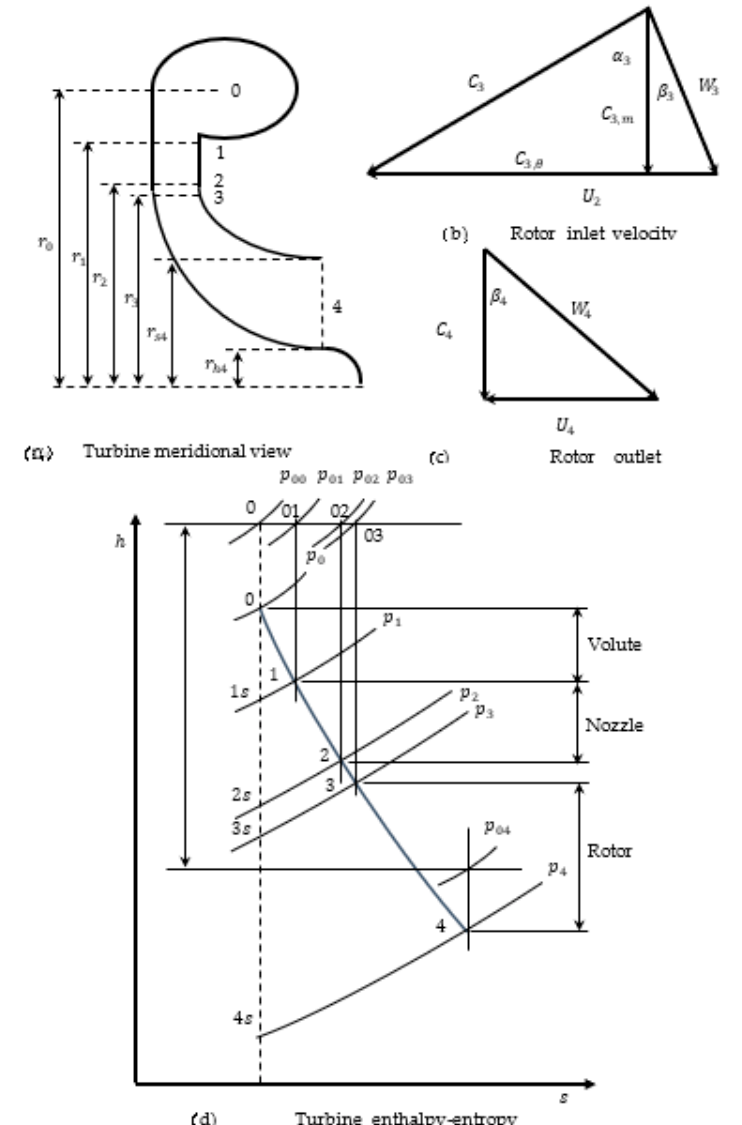
Figure 2. ( a ) Dimensions of the turbine, ( b ) velocity diagram at inlet, ( c ) velocity diagram at rotor exist, and ( d ) h-s diagram.